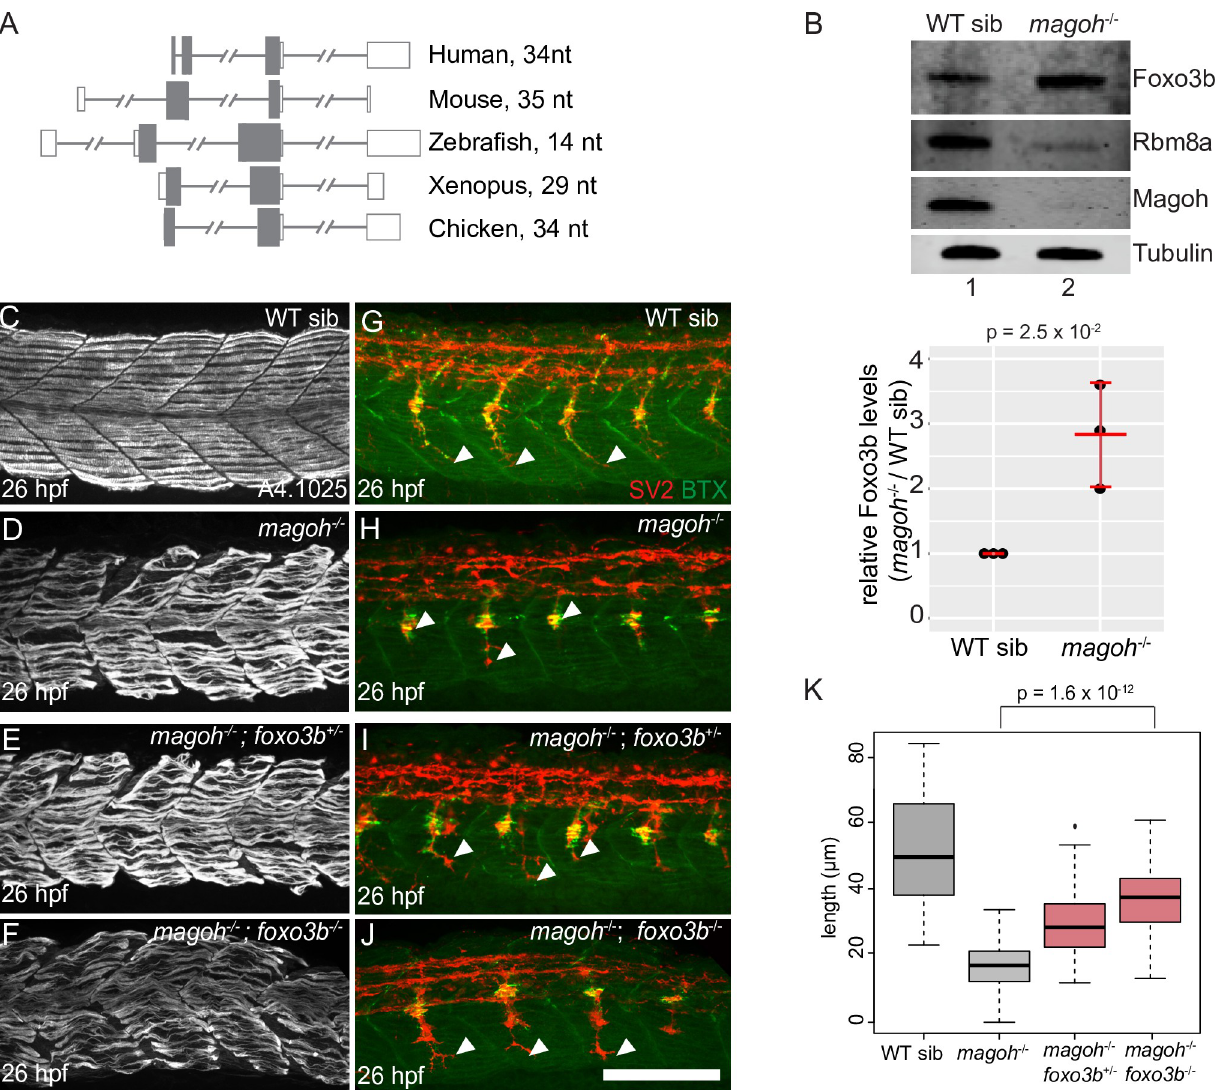
Fig 8. Partial or complete loss of foxo3b in magoh mutant embryos rescues motor neuron outgrowth defects. A. Illustration showing foxo3b gene structure in indicated vertebrates. The distance between the stop codon and the proximal 3 0 UTR intron is on the right. Open rectangles: UTRs, filled rectangles: coding region, gray lines: introns (hash marks denote shortened intron sequences). B. Top: Western blot showing protein levels in wild-type sibling (lane 1) and magoh mutant (lane 2) embryos at 21 hpf. Bottom: a dot plot showing Foxo3b levels normalized to tubulin levels in magoh mutant embryos and WT siblings at 21 hpf in three biological replicates. (N = 5 embryos per genotype per replicate). Error bars: standard error of means. C-F. Confocal images showing Myh1 immunofluorescence using anti-A4.1025 in somites 12–16 of WT sibling (C), magoh -/- mutant (D), magoh -/- ; foxo3b +/- mutant (E), and magoh -/- ; foxo3b -/- mutant (F) embryos at 26 hpf (N = 13 embryos/genotype). G-J. Merged confocal images showing motor neurons (red; detected by anti-SV2 staining) and acetylcholine receptors (green; detected by alpha-bungarotoxin staining) in somites 12–16 of WT sibling (G), magoh -/- mutant (H), magoh -/- ; foxo3b +/- mutant (I), and magoh -/- ; foxo3b -/- mutant (J) embryos. Neuromuscular junctions in the merged images are yellow. White arrowheads point to the distal end of the motor neuron. (N = 13 embryos per genotype). Scalebar in J (for panels C-J) is 100 nm. K. Boxplots showing quantification of motor axon length in embryos of genotypes indicated along the x-axis (4 motor neurons/embryo and 13 embryos/genotype). Welch’s t- test p-values for comparison between magoh -/- mutant and magoh -/- ; foxo3b -/- mutant embryos are at the